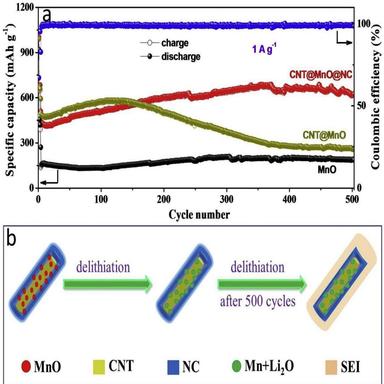
(a) Cycling performances of CNT@MnO@NC, CNT@MnO and MnO electrodes under a current density of 1.0 A g-1 . (b) Schematic illustration of behaviors for the CNT@MnO@NC electrode during the cycling process.